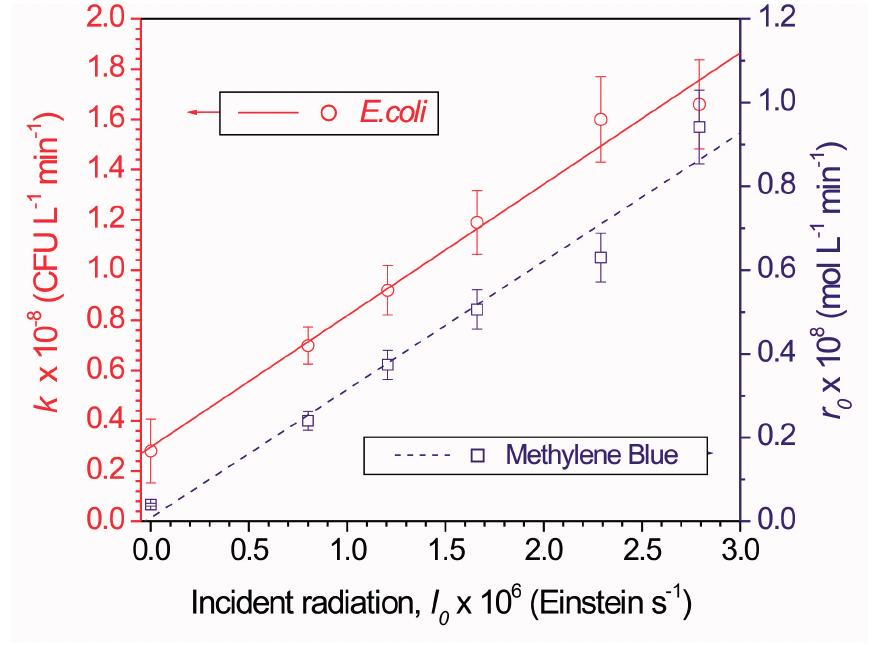
Figure 3. Kinetic constant for E. coli inactivation and initial reaction rate of methylene blue oxidation as a function of incident radiation. Reproduced from [39] with permission from